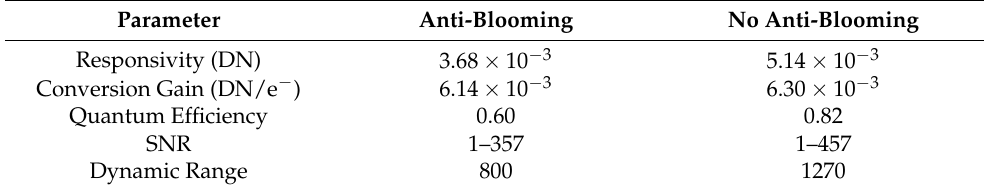
Table 1. Determined parameters for measurements with and without an anti-blooming mechanism for 64